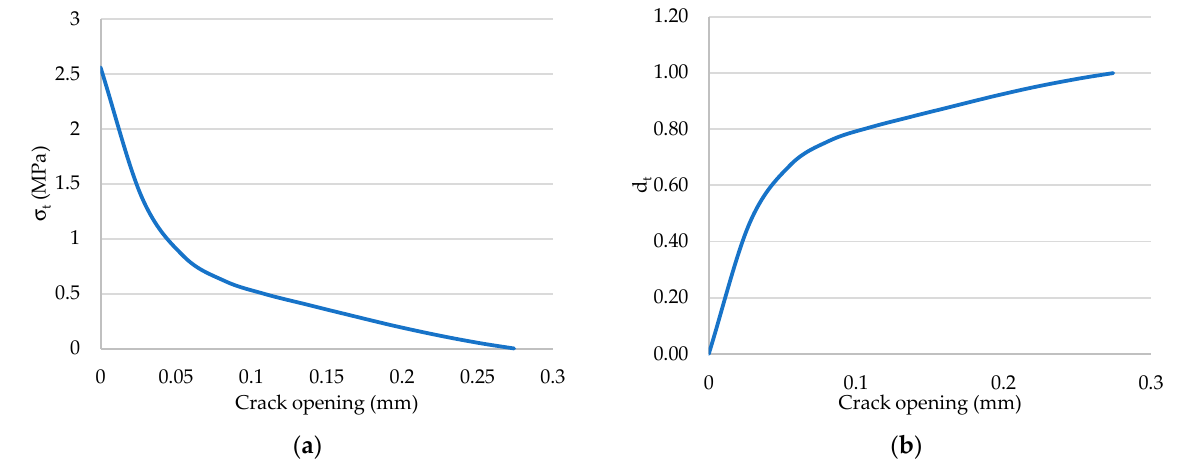
Figure 14. Parameters of concrete in tension: ( a ) tensile stress versus cracking displacement; ( b ) tensile damage versus cracking displacement.